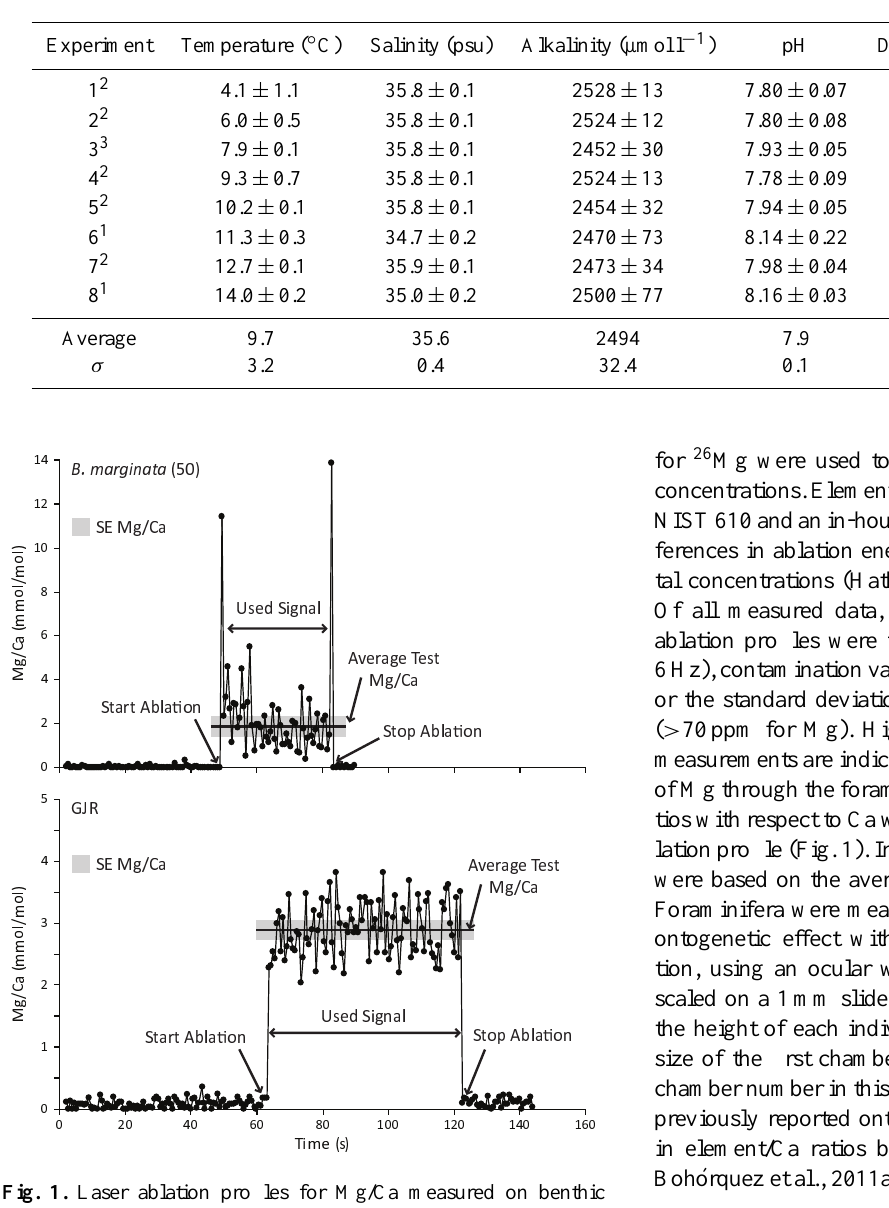
Fig. 1. Laser ablation profiles for Mg/Ca measured on benthic foraminifer B. marginata (upper panel) and the in-house GJR (Re- ichart et al., 2003) standard (lower panel). Parts of the profiles with elevated magnesium at the surface of the chamber walls are re- moved before calculating the average Mg/Ca. The absence of peak values for Mg/Ca in the GJR standard at the start and end of the ablation rule out any instrumental cause for the spikes observed in B. marginata